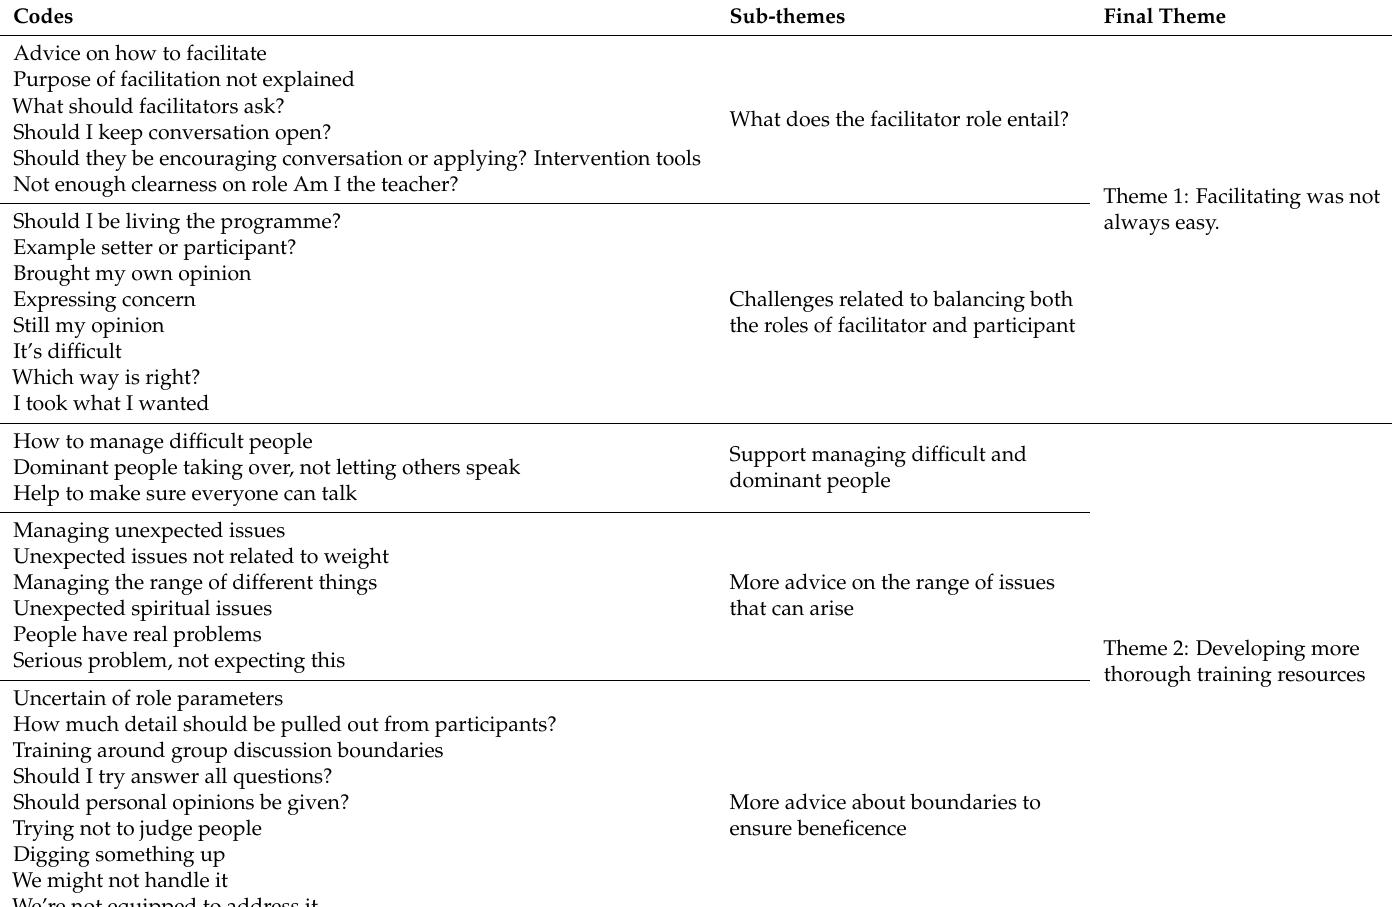
Table 4. Thematic map of the analysis process; displaying how codes were translated to